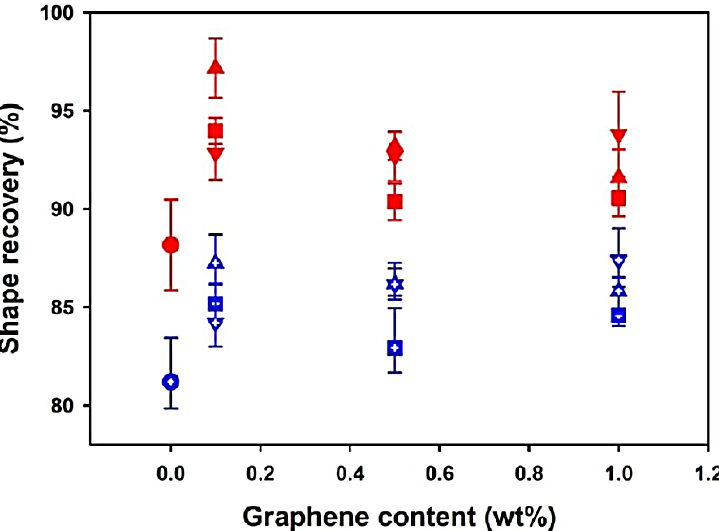
Figure 5. Shape recovery of pure PU and PU/graphene nanofiber webs with different cycles (red and solid symbols: first cycle; blue and open symbols: fifth cycle; ● PU; ■ PU/GO; ▲ PU/f-GO; and (cid:72) PU/r-GO) [113]. PU = polyurethane; PU/GO = polyurethane/graphene oxide; PU/f-GO = polyurethane/functional graphene oxide; PU/r-GO = polyurethane/reduced graphene oxide. Reproduced with permission from